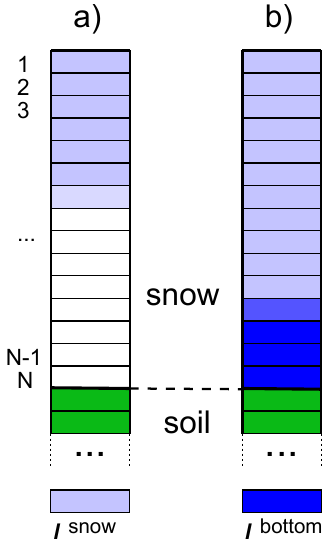
Fig. 3. Schematic description of the infiltration scheme, with snow grid cells numbered from j = 1 ,...,N . In case of light precipitation, the precipitation rate is distributed from top to bottom (a) , while water starts pooling at the bottom for strong precipitation (b) . Note that the maximum infiltration rates I snow and I bottom of each grid cell vary depending on temperature, water content and total water and ice content. See